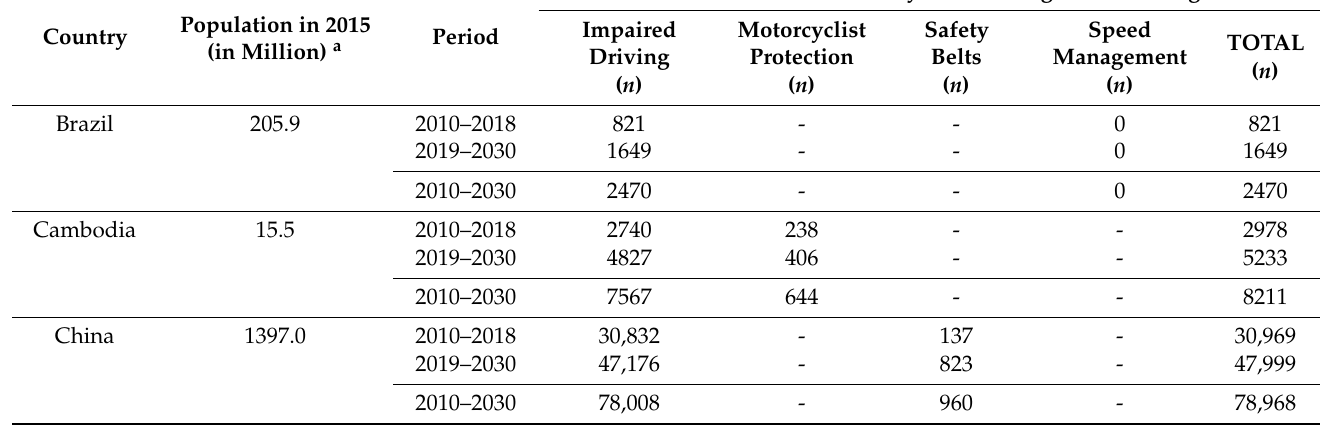
Table A2. The Pilot Phase (2007–2009), the GRSP (2010–2014), and BIGRS (2015–2019): Estimates of Lives Saved by Changes to Road Safety